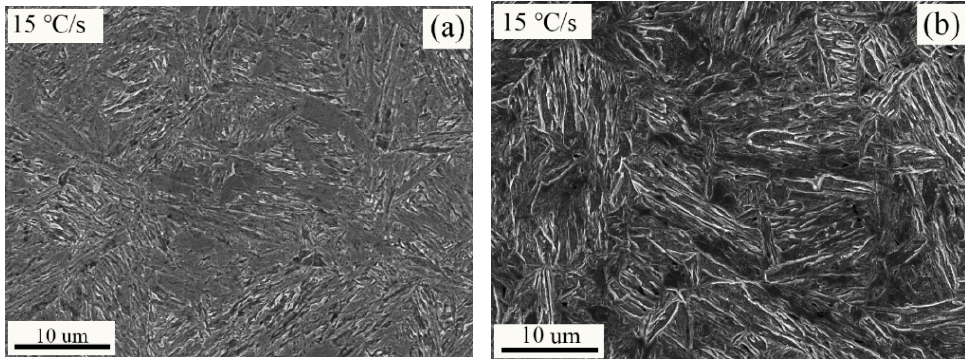
Figure 8. The microstructure of the carburised layer ( a ), the matrix ( b ) at a cooling rate of 15 °C/s.